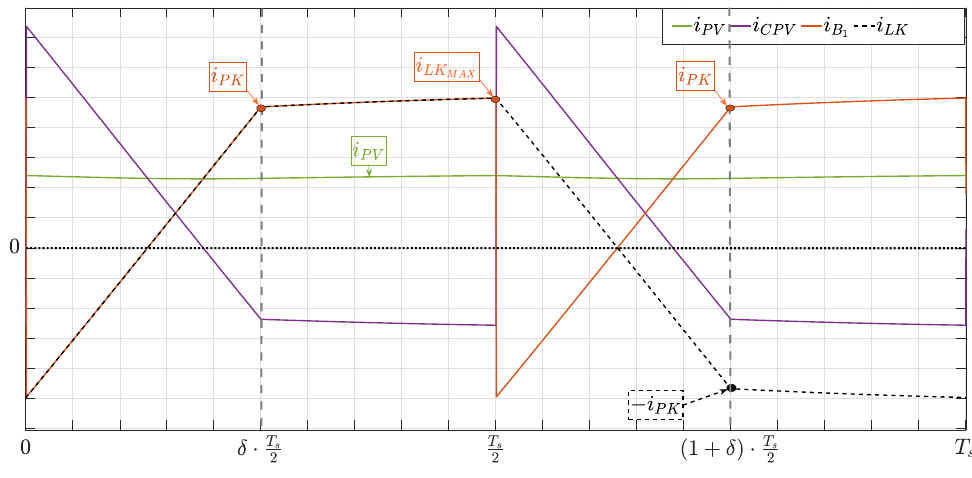
Figure 4. Input node currents of DAB